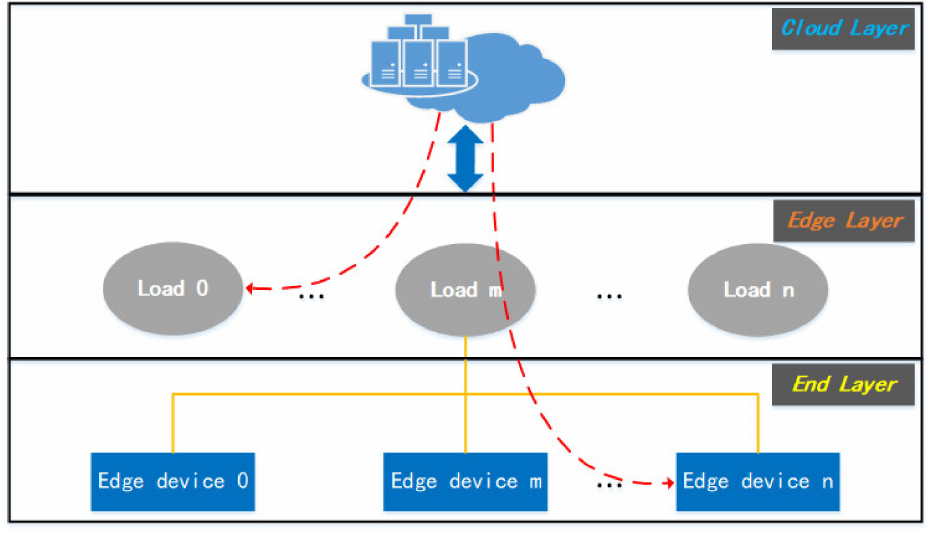
Figure 1. Cloud-Edge-End Collaboration